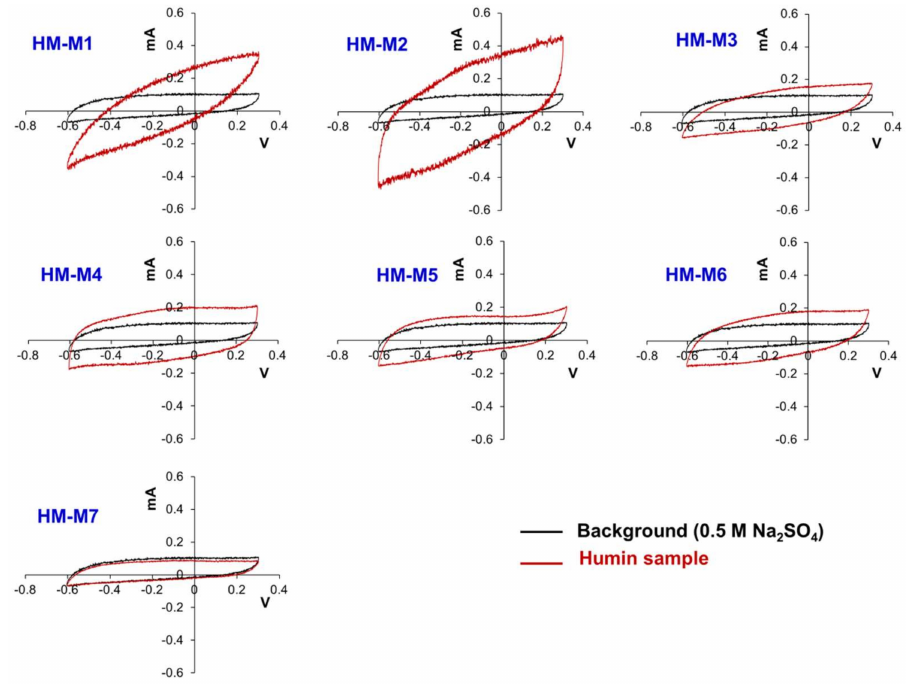
Figure 8. Cyclic voltammogram of the seven humin (HM)